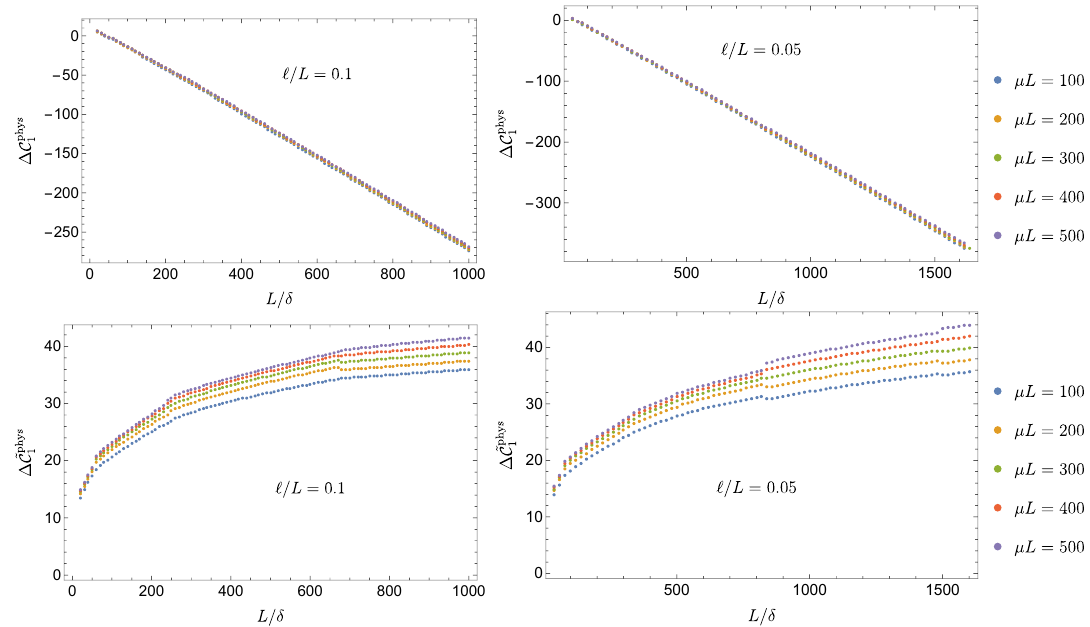
Figure 22 . The two de(cid:12)nitions of mutual complexity in the physical basis (cid:1) C phys function of the cuto(cid:11) for various reference frequencies (cid:22)L = 100, 200, 300, 400 and 500. The mass was set to mL = 0 :